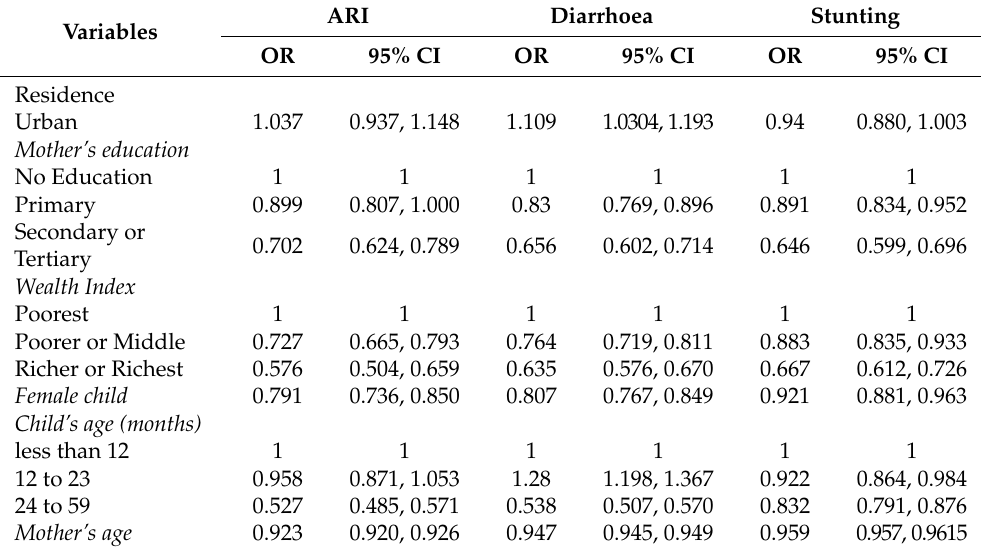
Table 7. The odds ratio estimates of the covariate effects and their 95% credible interval for combined